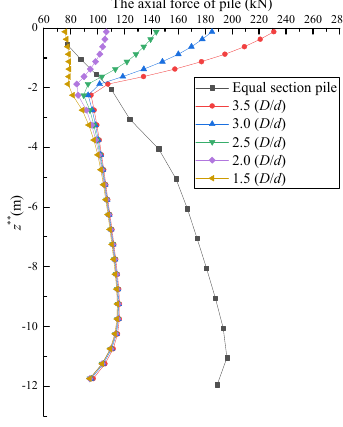
Appl. Sci. 2019 , 9 , 2658